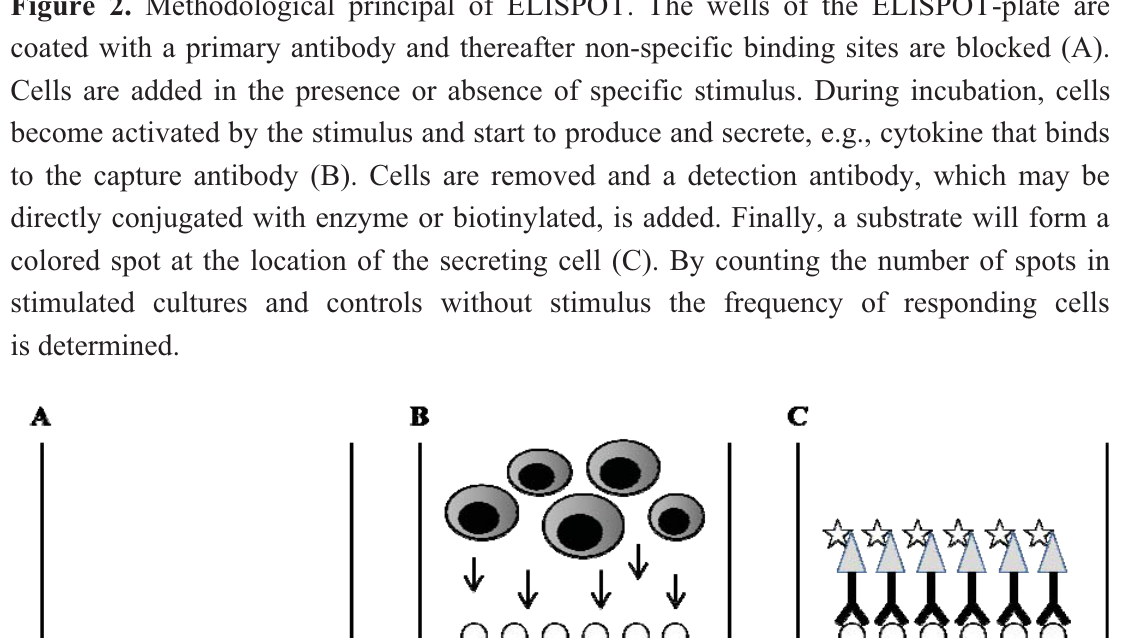
Figure 2. Methodological principal of ELISPOT. The wells of the ELISPOT-plate are coated with a primary antibody and thereafter non-specific binding sites are blocked